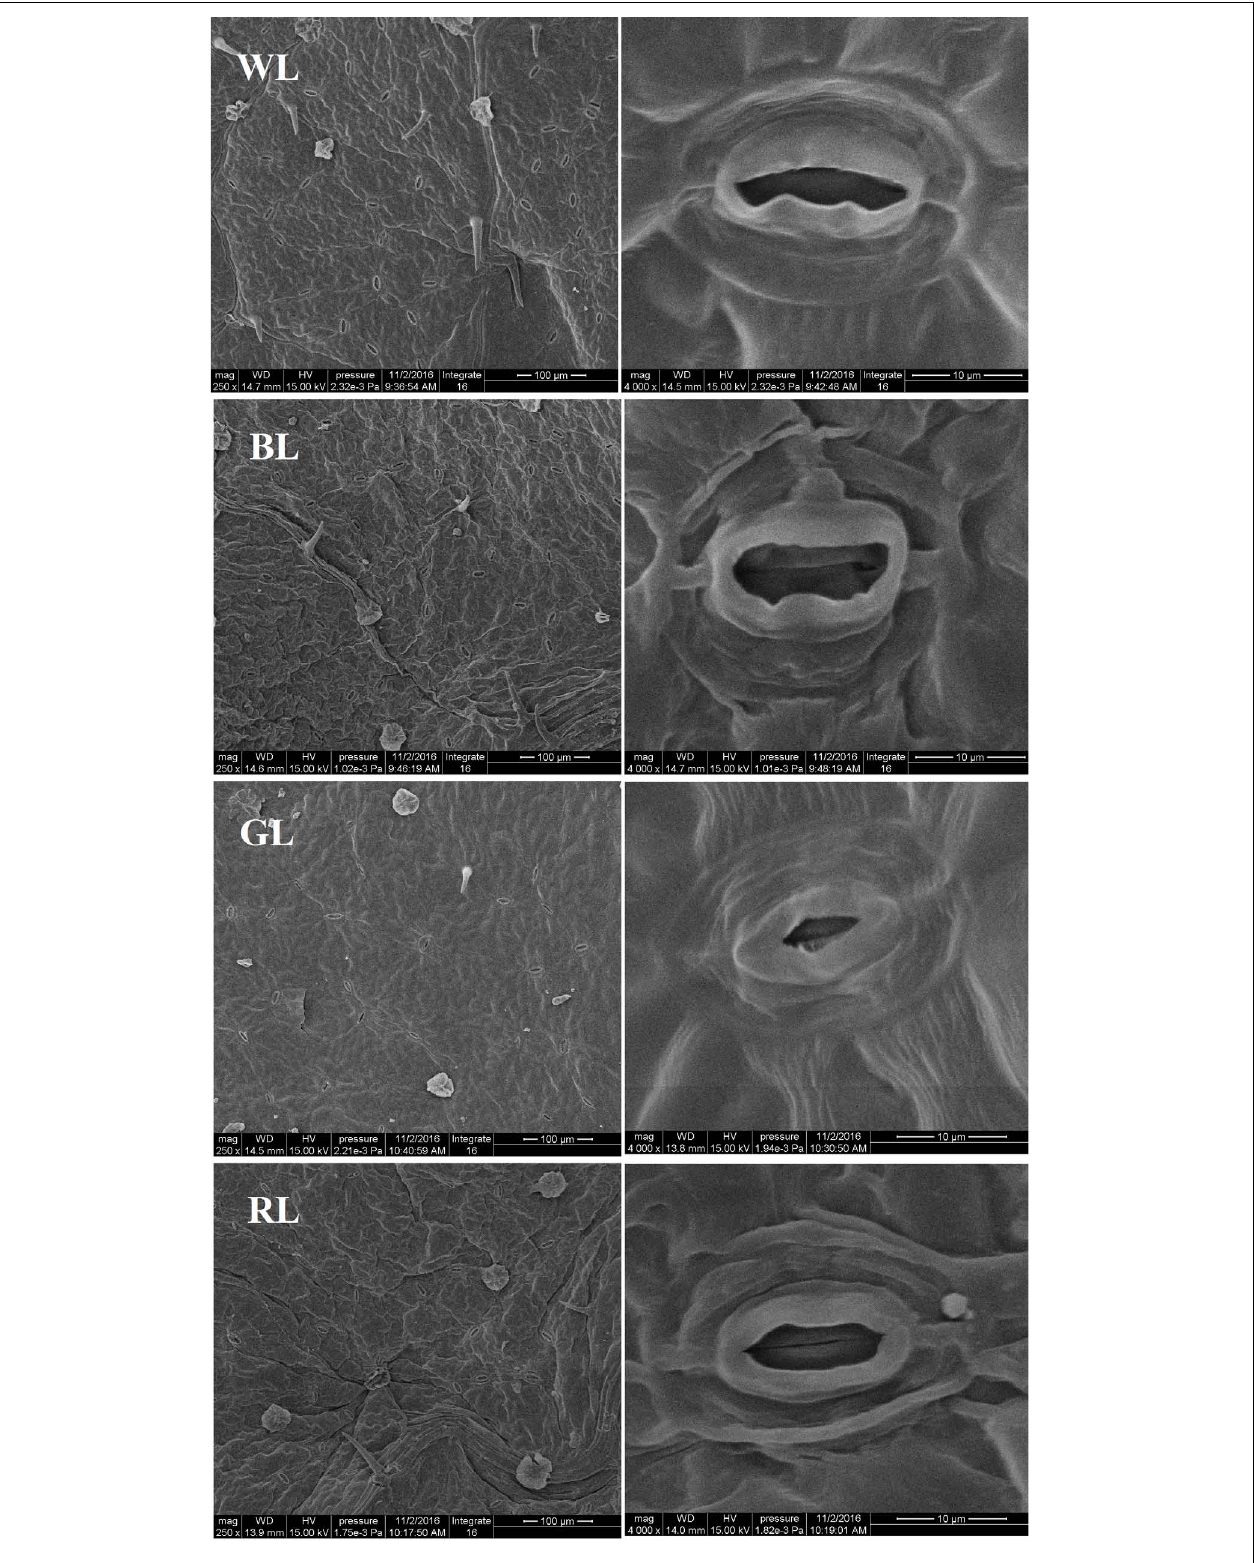
FIGURE 3 | Structure of stomata from C. paliurus leaves under different light treatments. Scale: 100 µ m (left) and 10 µ m (right) .